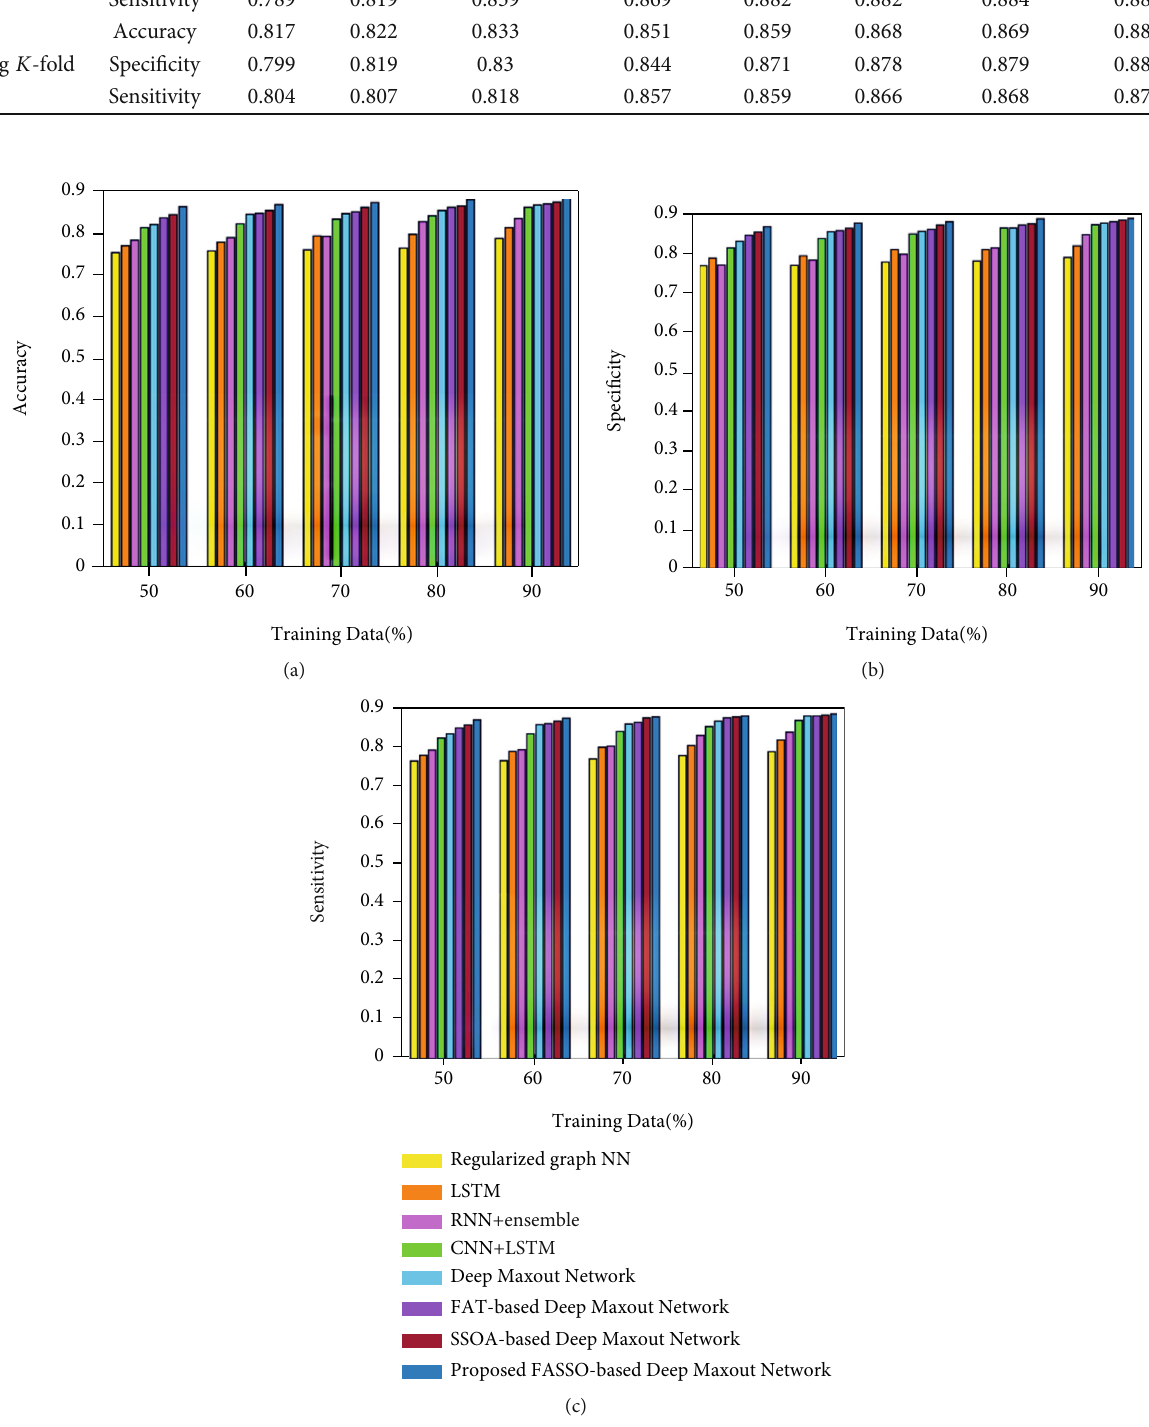
Figure 5: Assessment using training data: (a) accuracy, (b) speci fi city, and (c) sensitivity.